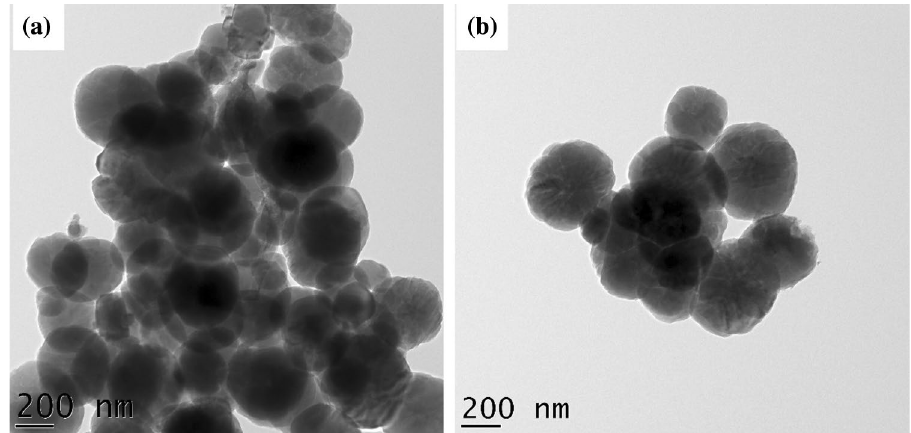
Fig. 3 SEM micrographs of a, b conventional and c, d mesoporous silicalite-1 Fig. 4 TEM images